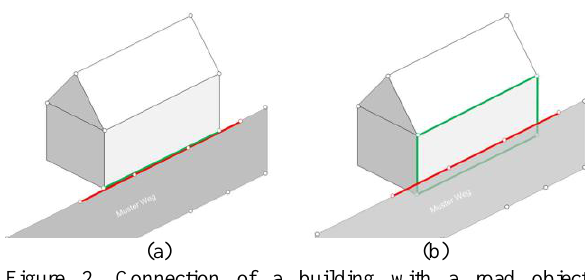
Figure 2. Connection of a building with a road object represented by (a) a line connector and (b) a surface connector at the